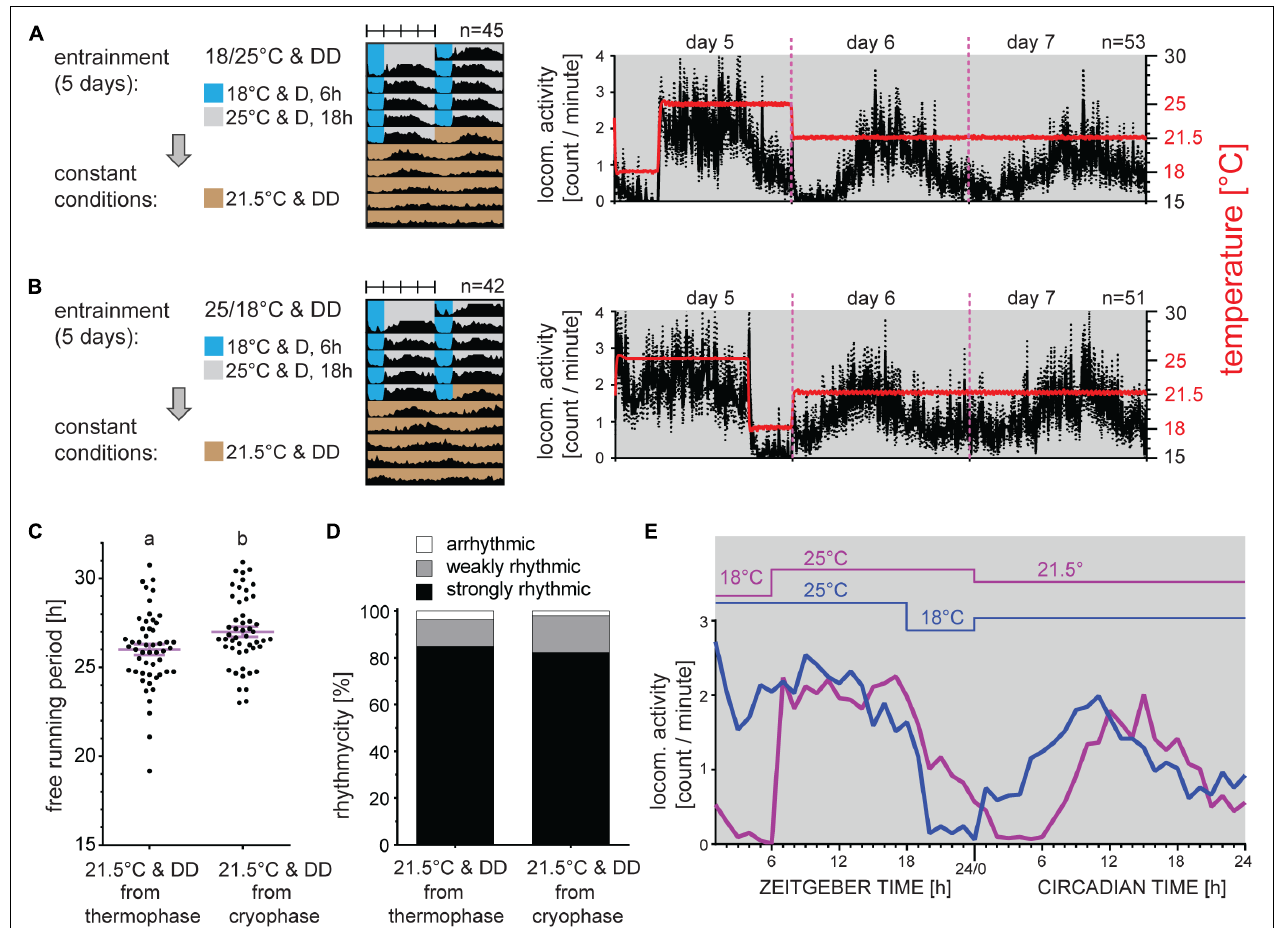
FIGURE 3 | Phase of activity is defined by the thermophase. Adult males developing under long photoperiod (D6:L18) were entrained by 5 days of constant dark and long thermoperiod 18:6 with thermophase at 25 ◦ C and cryophase at 18 ◦ C. Then, males were released to intermediate temperature (21.5 ◦ C) either from the thermophase (A) or from the cryophase (B) . Double-plotted actograms represent the average activity of all males rhythmic under constant conditions (see panel (D) for the percent rhythmicity). Detailed activity profile is plotted from all males for day 5–7 [right panels in (A,B) ]. The actual temperature recorded during the experiment is shown in red (right y -axis). Detail activity profiles averaged into 1-h bin are shown for the last day of thermoperiodic entrainment and the first day of constant conditions (E) . The rhythmicity under constant conditions was determined from 10 days and is presented as the free-running period of each individual male (dots) and mean ± SEM shown in magenta (C) , where different small letter above categories indicate statistical difference p < 0.05 ( t -test). The percent of arrhythmic, weakly rhythmic and strongly rhythmic males is shown in panel (D) .